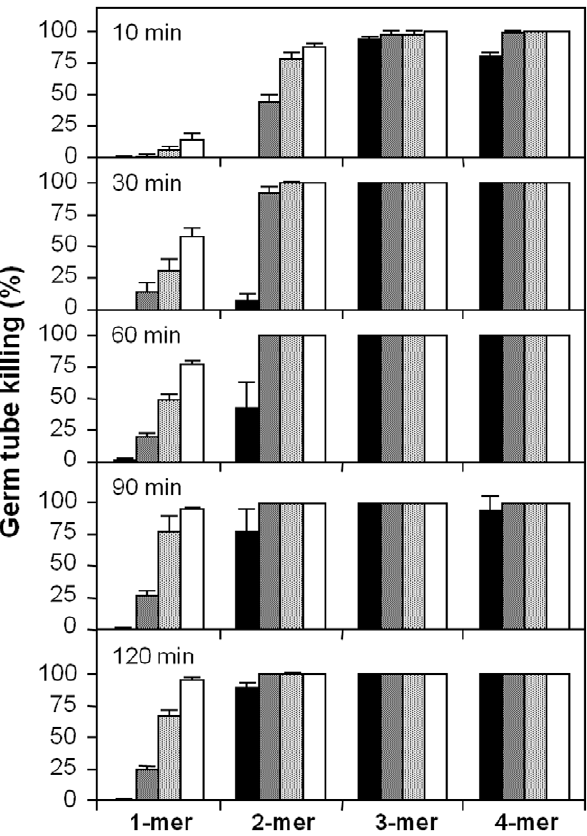
Figure 6. Time dependent killing activity of recombinant histatin 3 variants. Germ tubes were incubated with histatin 3 variants for 10, 30, 60, 90 and 120 min. Peptide concentrations of 1.56 m M (black bars), 3.13 m M (crosshatched bars), 6.25 m M (dotted bars) and 12.5 m M (white bars) were employed. Experiments were conducted in duplicate and the average and deviation from the mean are shown. template (data not shown). Three sequential PCR reactions were carried out to prepare recombinant histatin variants with two,